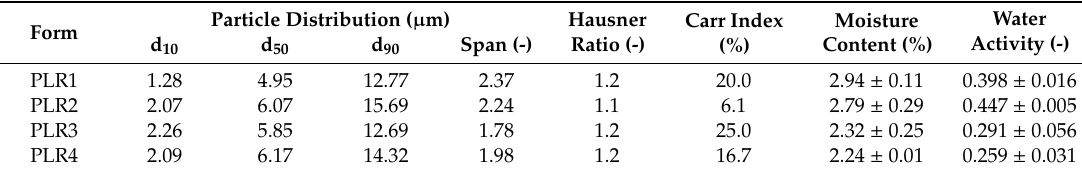
Table 3. Powder characterization (optical micrography) and flow properties of spray-dried lipid